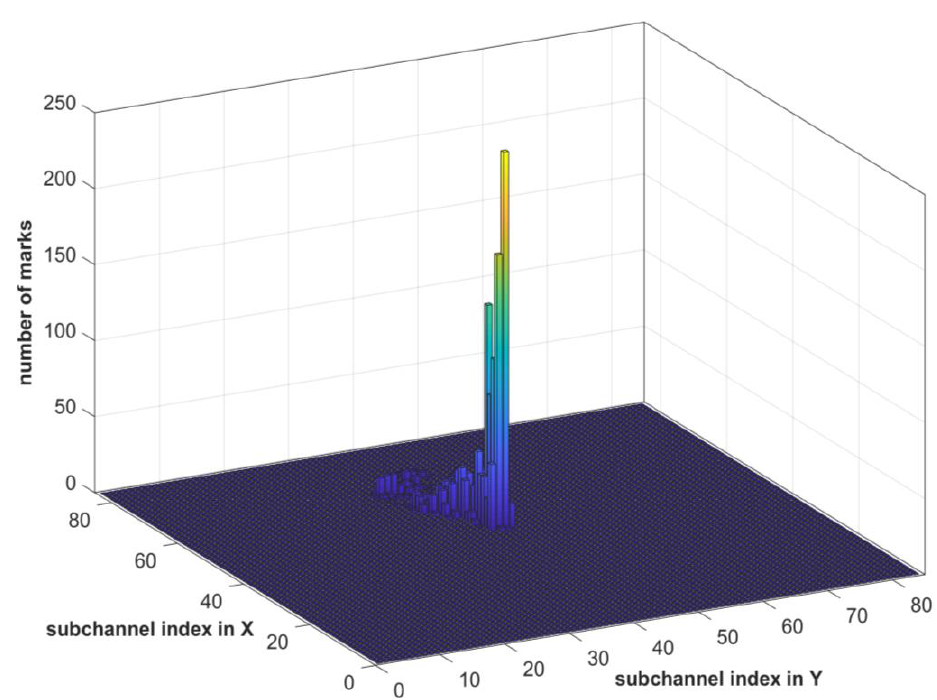
Fig. 5. The example of atmospheric particles marks distribution in XY plane (H =3750…5000 m, V r = - 8,7… -7,0 m/sec). The information about the marks is gathered from 3 scan